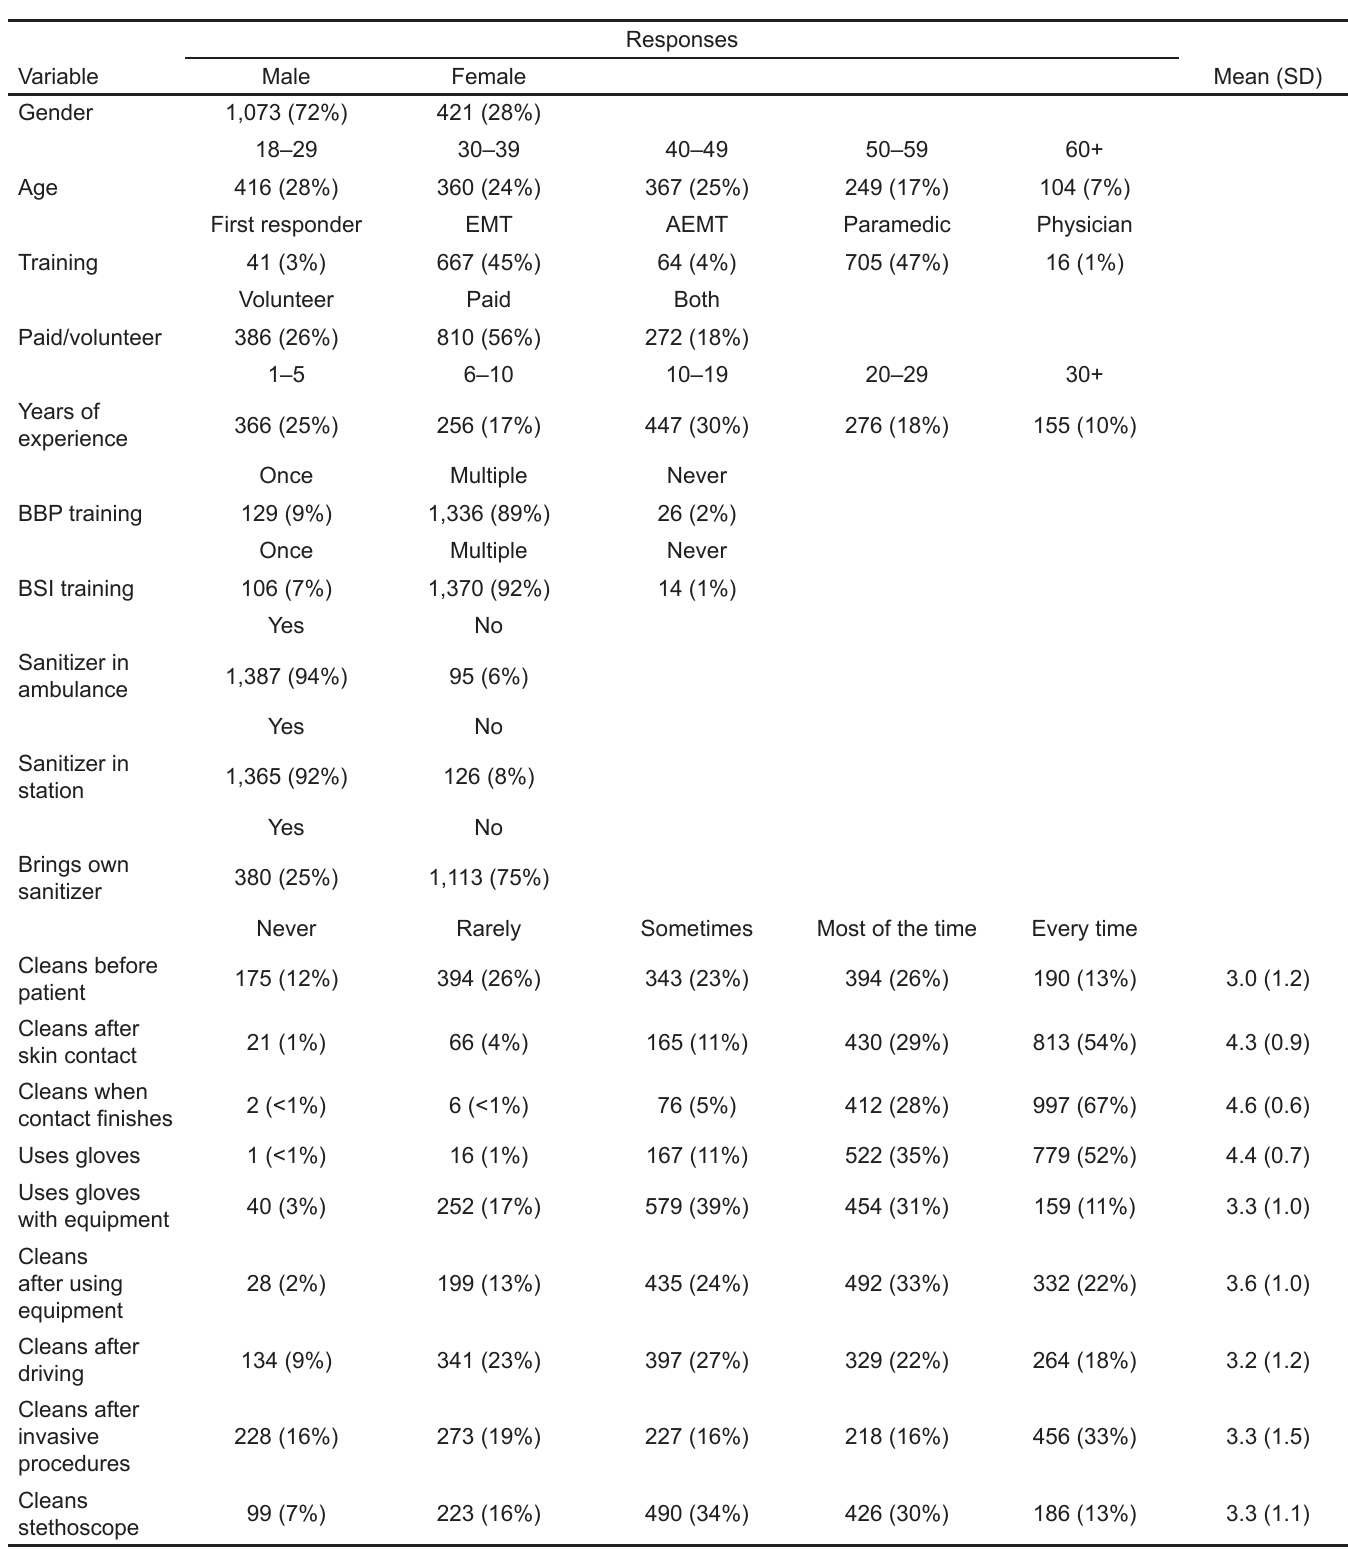
Figure 1. Frequencies (percentages) and means (standard deviations, SDs) for participant characteristics and responses of emergency medical services personnel in hand hygiene